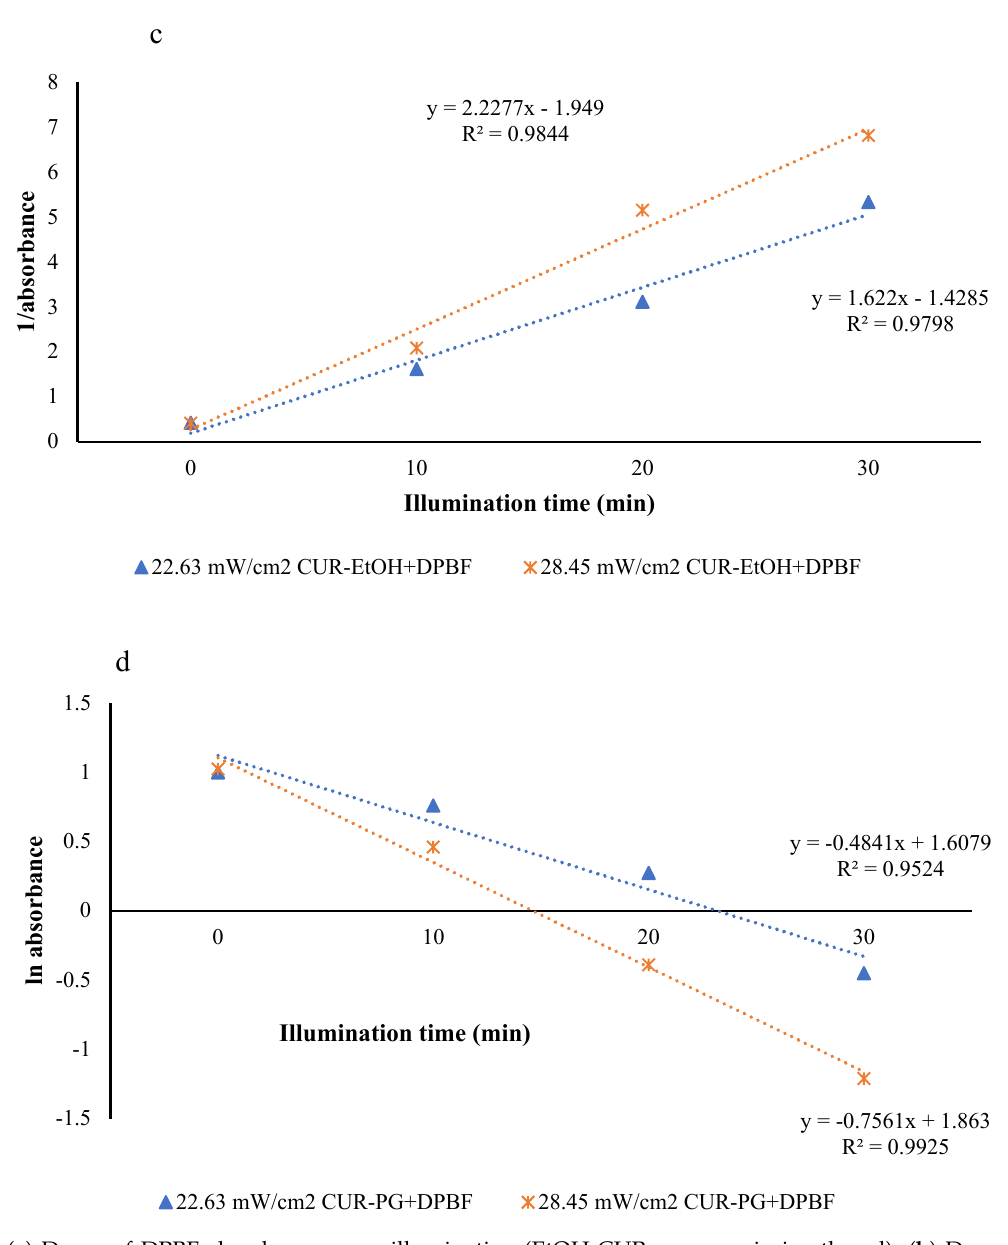
Figure 3. ( a ) Decay of DPBF absorbance upon illumination (EtOH-CUR = curcumin in ethanol); ( b ) Decay of DPBF absorbance upon illumination (CUR-PG = curcumin in 50% propylene glycol); ( c ) Kinetic decay of DPBF absorbance in ethanolic curcumin solution (second-order kinetics); ( d ) Kinetic decay of DPBF absorbance in curcumin-propylene glycol solution (first-order kinetics). Data are means ± SE ( n = 3).